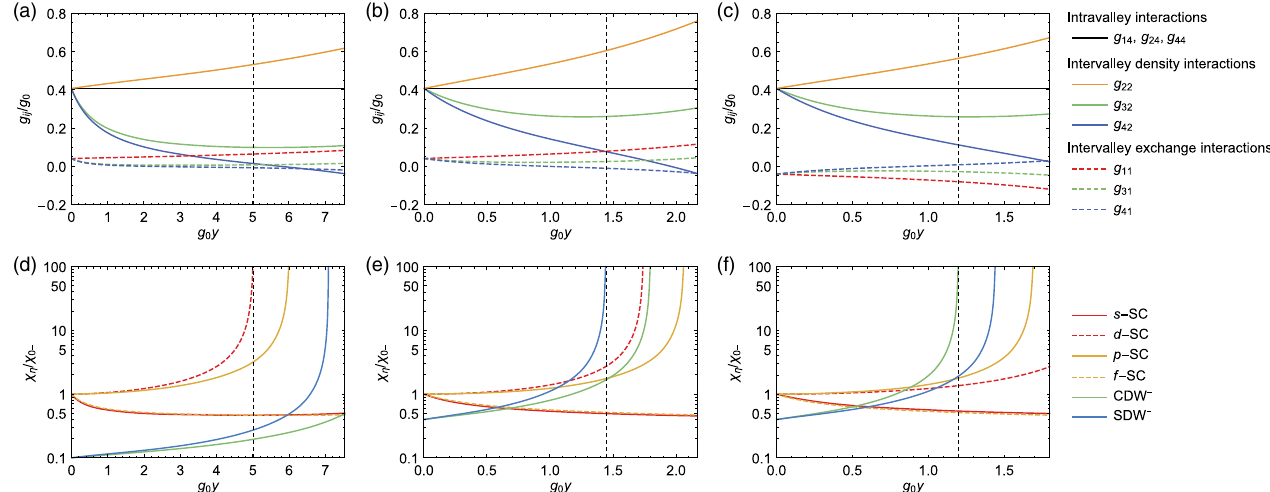
FIG. 5. Effect of the exchange interactions. (a) – (c) Running coupling constants and (d) – (f) susceptibilities for possible orderings. We choose the strengths of density-density interactions g 14 ¼ g 24 ¼ g 44 ¼ 1 (intravalley) and g 22 ¼ g 32 ¼ g 42 ¼ 1 (intervalley). Fermi surface nesting is weak in (a) and (d) with d 1 − ¼ 0 . 1 and strong in (b), (c), (e), and (f) with d 1 − ¼ 0 . 4 . Finite exchange interactions lift the degeneracies of susceptibilities, cf. Figs. 4(e) and 4(f). We choose the exchange interactions to be initially repulsive ( g 11 ¼ g 31 ¼ g 41 ¼ 0 . 1 ) in (a), (b), (d), and (e) and attractive ( g 11 ¼ g 31 ¼ g 41 ¼ − 0 . 1 ) in (c) and (f). The vertical dashed lines indicate the positions where instabilities